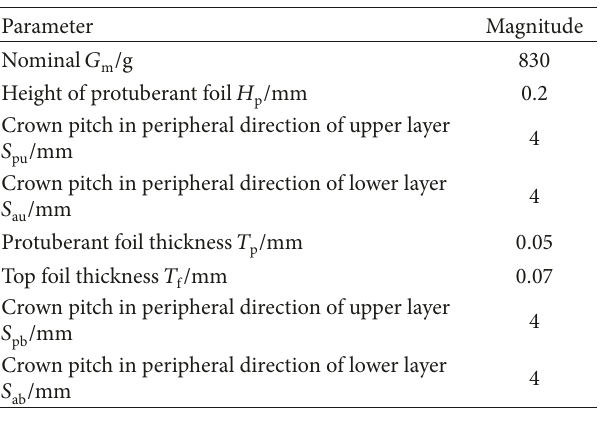
Table 2: Geometrical parameters of the protuberant foil journal bearing [31].